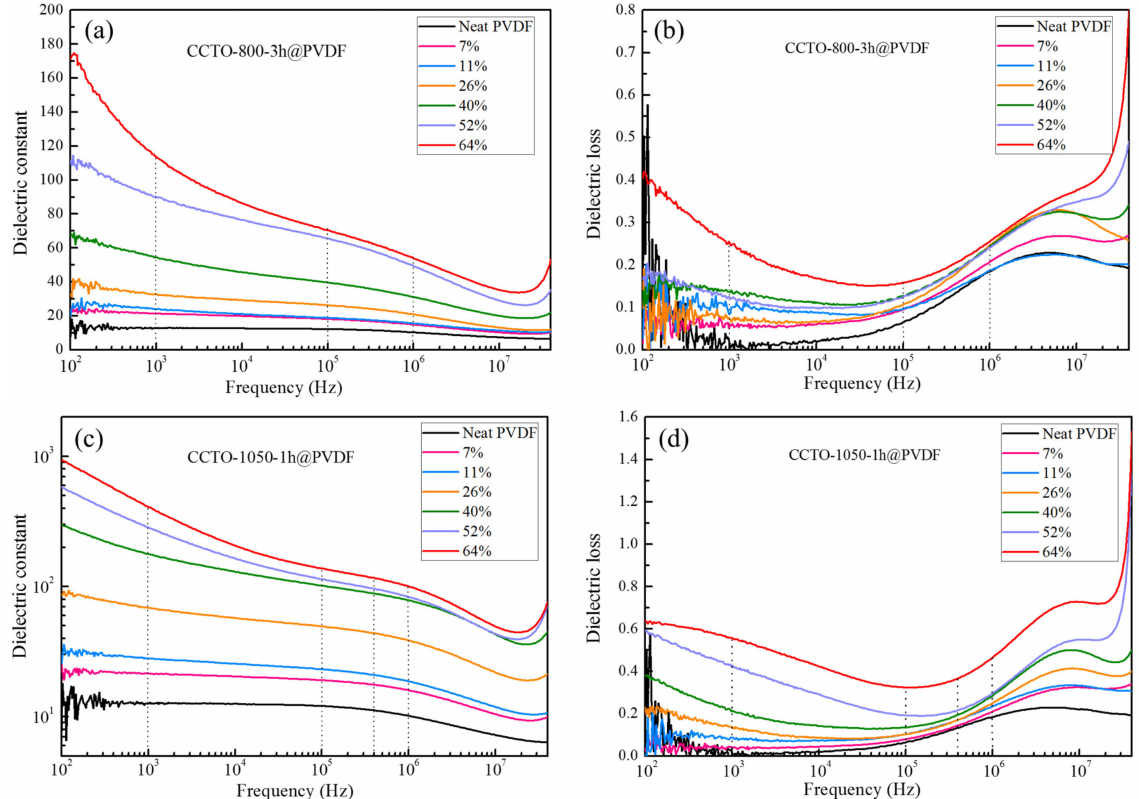
Figure 9. The frequency dependence of dielectric constants and ( ε ) and dielectric loss (tan δ ) of CCTO- 800-3 h@PVDF ( a , b ) and CCTO-1050-1 h@PVDF ( c , d ) at various volume fractions at room